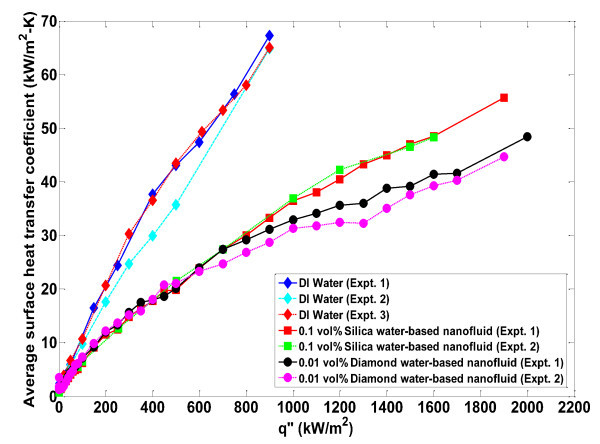
Average wall heat transfer coefficient as a function of applied heat flux. Uncertainty in heat transfer coefficient is ± 3%.